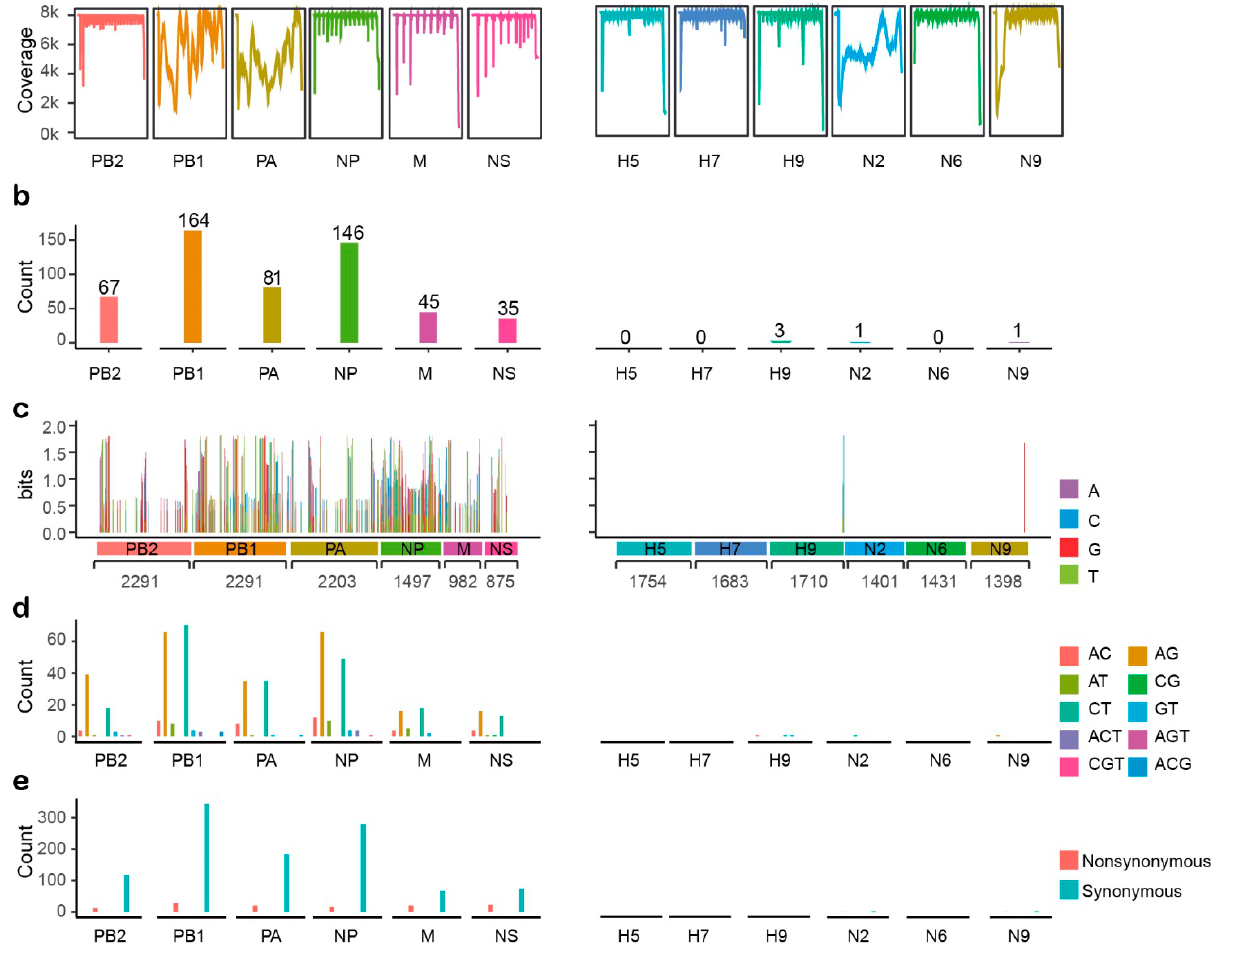
Figure 1. Statistical analyses of Illumina data. ( a ) Reads coverage for each segment of influenza A virus genome. ( b ) Number of SNPs in each segment. ( c ) Stack column plots shew variation distribution of each site along each segment. The column height depicts the information content, in bits. ( d ) The number of heterozygous base compositions in all variation sites for each segment. ( e ) The number of synonymous and nonsynonymous sites of each segment.